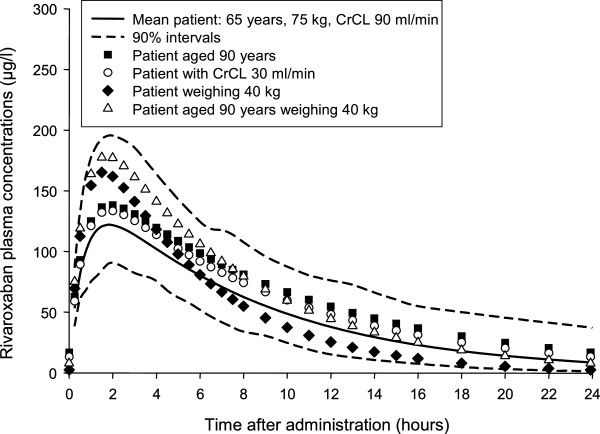
Simulations of rivaroxaban plasma concentration–time profiles in typical patients compared with overall population estimates. Typical patients are elderly (90 years), have moderate to severe renal impairment; CrCl 30 ml/min), have low body weight (40 kg), or are elderly with low body weight. Patients receiving rivaroxaban 10 mg once daily (mean with 90% interval) [11]. CrCL/CrCl, creatinine clearance. Reproduced with permission from Mueck W, Borris LC, Dahl OE et al. Population pharmacokinetics and pharmacodynamics of once- and twice-daily rivaroxaban for the prevention of venous thromboembolism in patients undergoing total hip replacement. Thromb Haemost 2008;100:453–461.